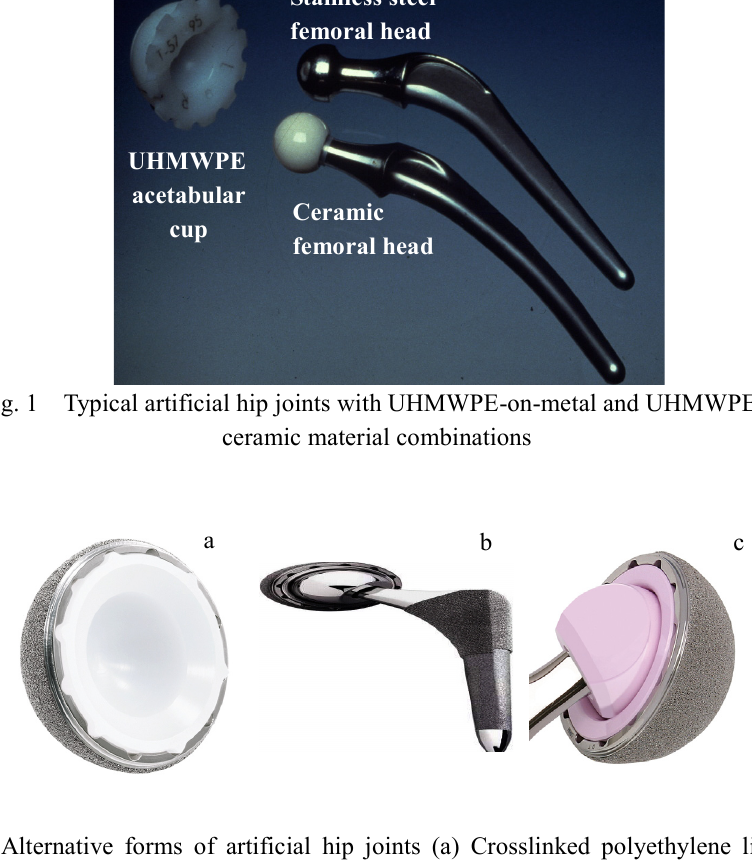
Fig. 2 Alternative forms of artificial hip joints (a) Crosslinked polyethylene liner in a Titanium shell (Marathon liner in Pinnacle shell, DePuy International Ltd, Leeds, UK); (b) Ultamet® metal-on-metal total hip replacement (Ultamet liner in Pinnacle shell and Ultamet head, DePuy International Ltd, Leeds, UK) and (c) Ceramax® ceramic-on-ceramic total hip replacement (Biolox Delta liner in Pinnacle shell and Biolox Delta head, DePuy International Ltd, Leeds,